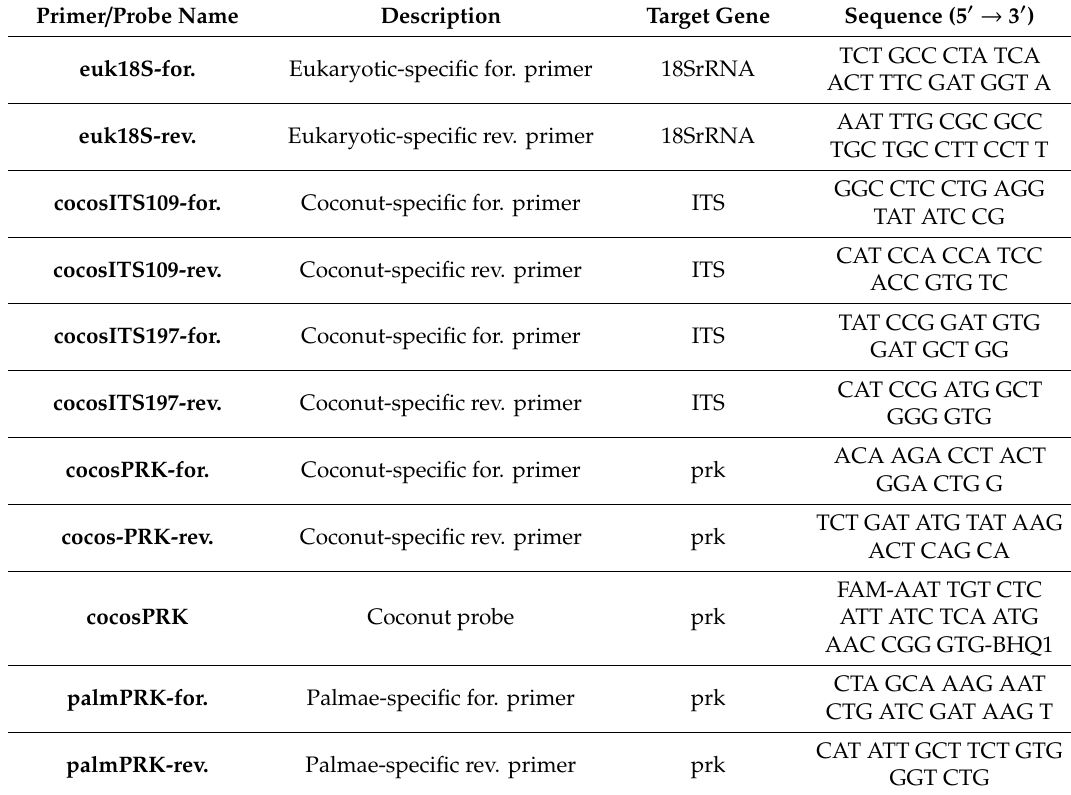
Table 1. DNA sequences and description of the forward ( = for.) and reverse ( = rev.) primers and probes listed